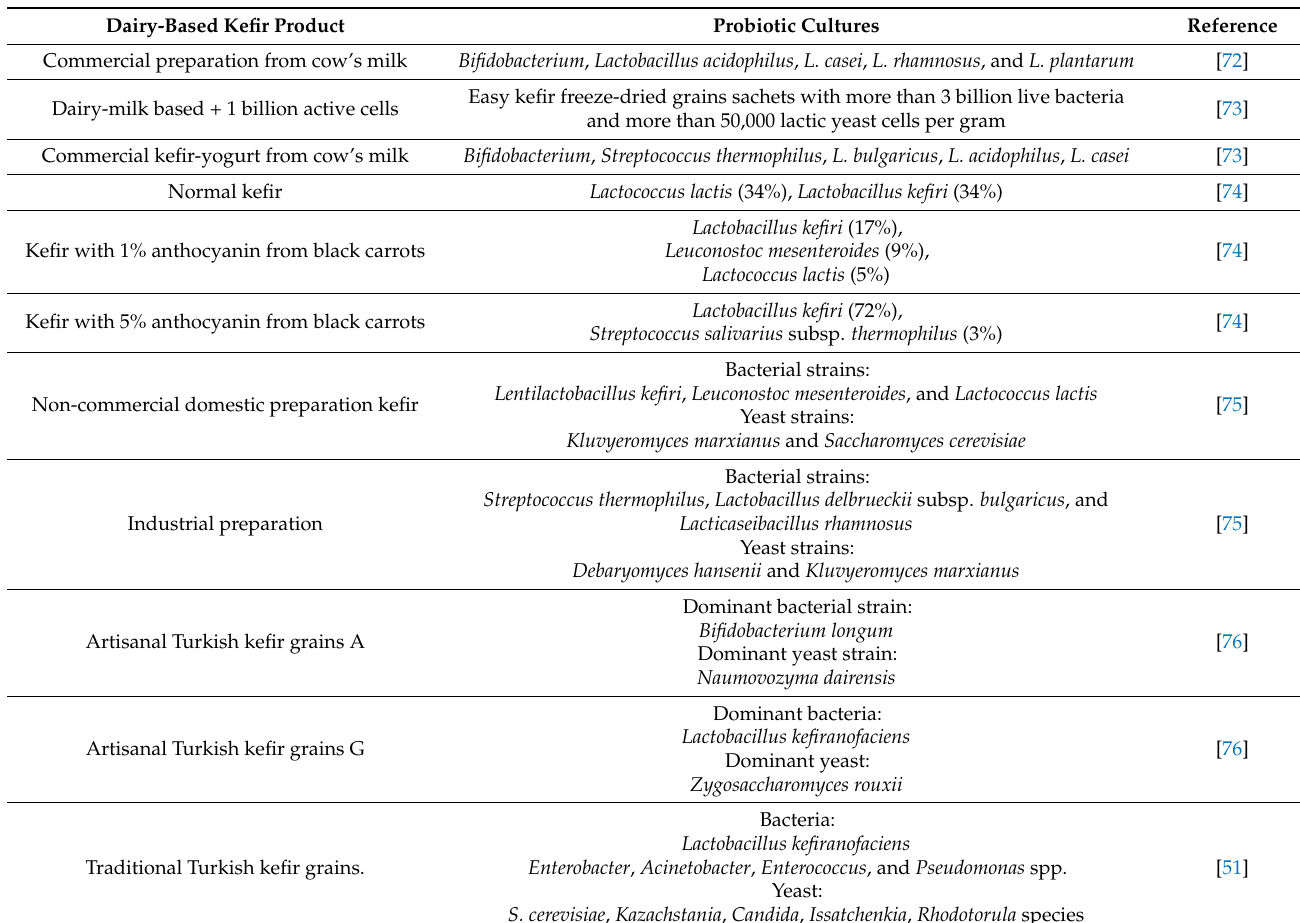
Table 1. Kefir prepared from dairy sources as a probiotic beverage for lactose-tolerant and non- vegan